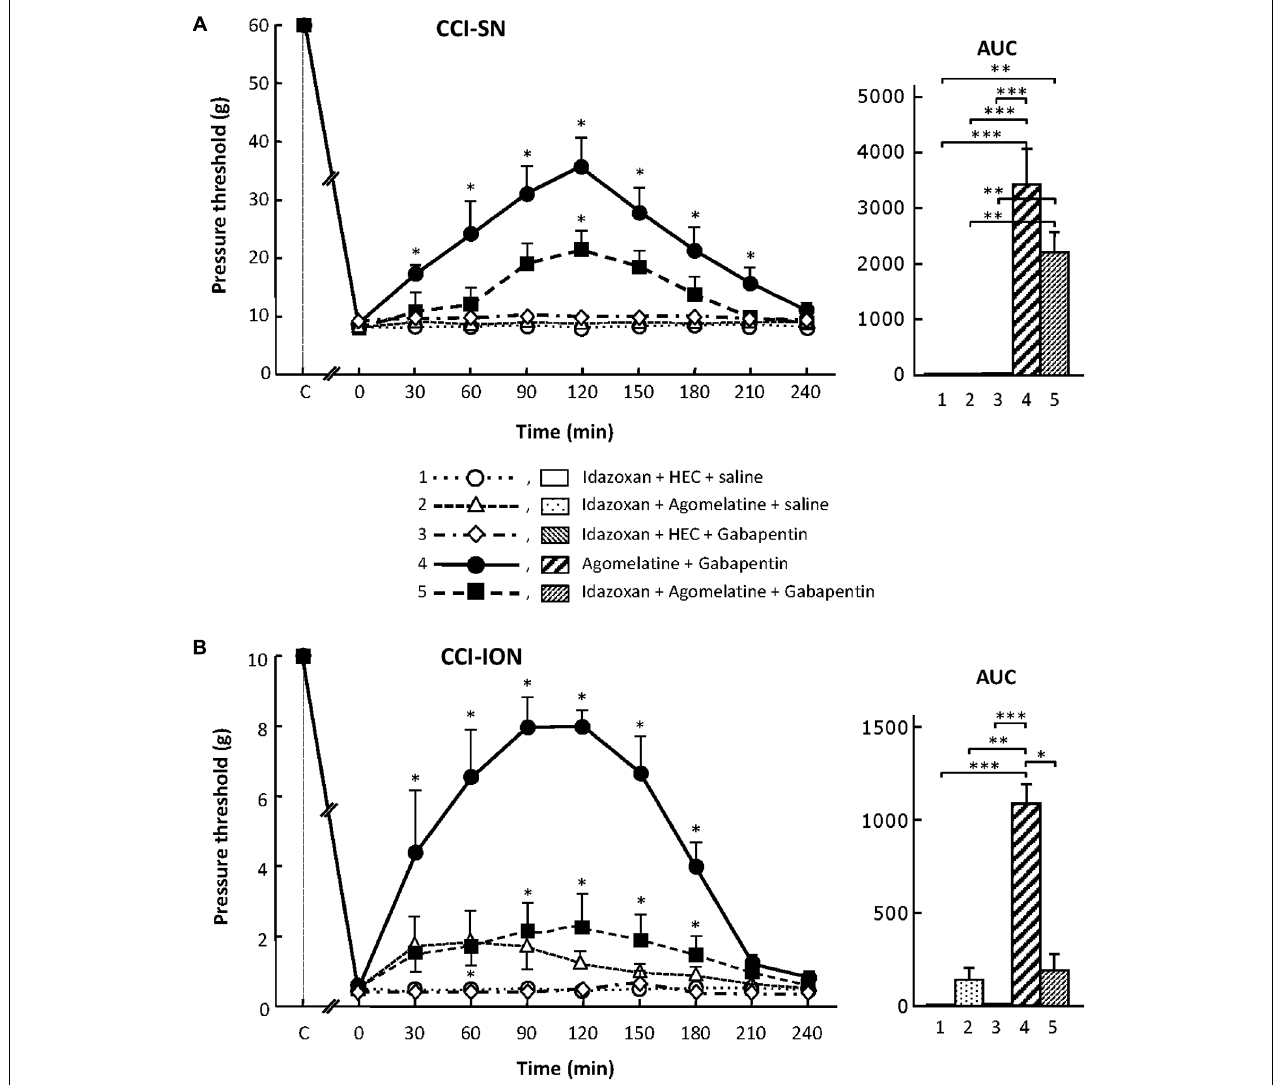
FIGURE 6 | Effects of idazoxan alone or co-administered with agomelatine, gabapentin or ‘agomelatine + gabapentin’ on mechanical allodynia in CCI-SN (A) and CCI-ION (B) rats. Left panels: Idazoxan (2 mg/kg i.p.) or its vehicle (saline) was administered 30 min before other treatments in rats whose right SN (A) or ION (B) had been ligated 2 weeks before. Five different treatment groups were made: (1) idazoxan + HEC + saline, (2) idazoxan + agomelatine (45 mg/kg) + saline, (3) idazoxan + HEC + gabapentin (50 mg/kg), (4) agomelatine + gabapentin, (5) idazoxan + agomelatine + gabapentin. Pressure threshold values (as g) were determined as described in the legend to Figure 1 . Each point is the mean ± SEM of independent determinations in n rats for each condition. ∗ P < 0.05, compared with pressure threshold values determined just prior to treatments (0 on abscissa), one way ANOVA with repeated measures, Dunnett’s test. C on abscissa: intact healthy rats before surgery. In both CCI-SN (A) and CCI-ION (B) rats, ‘saline+HEC’-treated groups were also included, but, for the sake of clarity, corresponding data are not represented as they superimposed with those obtained in rats treated with idazoxan + HEC + saline. Right panels: AUC values calculated from the respective time-course curves: (1) idazoxan + HEC + saline [ n = 7 (A) , n = 5 (B) ]; (2) idazoxan + agomelatine + saline ( n = 6/6); (3) idazoxan + HEC + gabapentin ( n = 6/5); (4) agomelatine + gabapentin ( n = 7/6); 5 = idazoxan + agomelatine + gabapentin ( n = 7/14). A- CCI-SN : one way ANOVA [ F (4,28) = 16.33, P < 0.0001] followed by Tukey’s test ( ∗∗ P < 0.01, ∗∗∗ P < 0.001); B- CCI-ION : one way ANOVA [ F (4,35) = 8.267, P < 0.0001] followed by Tukey’s test ( ∗ P < 0.05, ∗∗ P < 0.01, ∗∗∗ P <